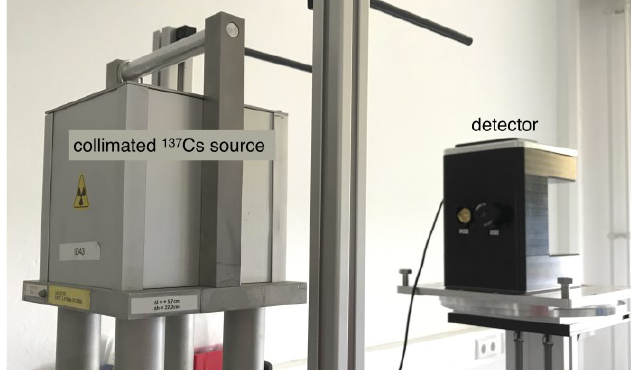
Figure 4. The developed detection system was irradiated with a collimated 137 Cs source to determine quantitative dose/dose rate values.